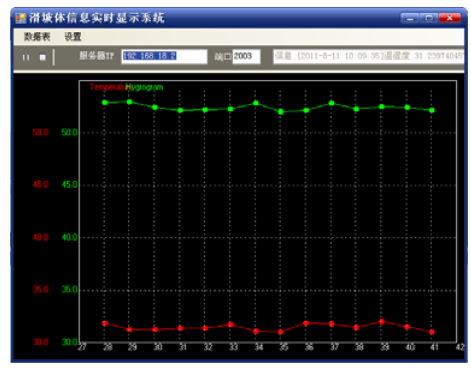
Figure 7. Client software for narrowband sensor network data